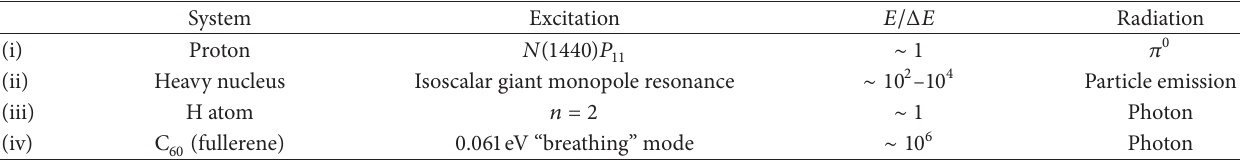
Table 1: Properties of some relevant quantum-mechanical